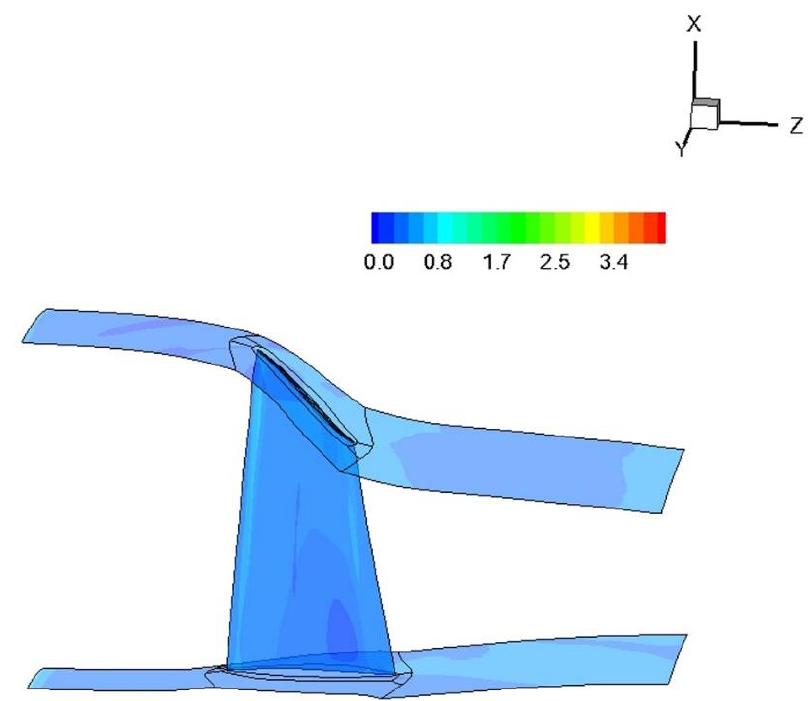
Figure 6. Distribution of y+ on walls of the hub, blade, and shroud.